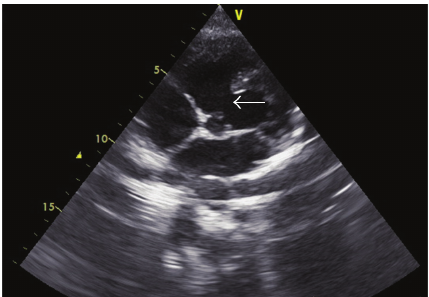
Figure 2: Transthoracic echocardiography: 5-chamber view shows a large malaligned nonrestrictive subaortic VSD (thin arrow).